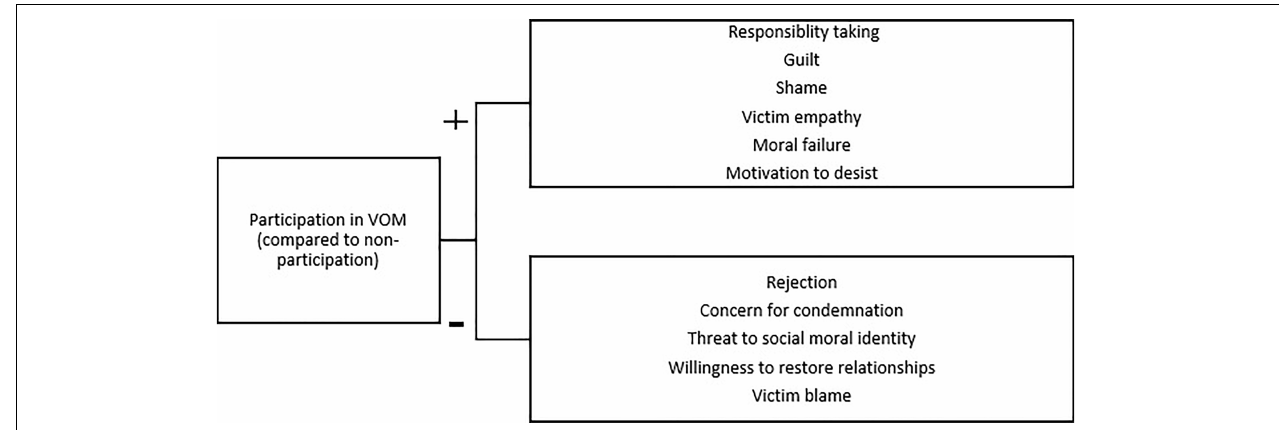
FIGURE 1 | Overview of the hypothesized relations between participation in VOM and the dependent variables of